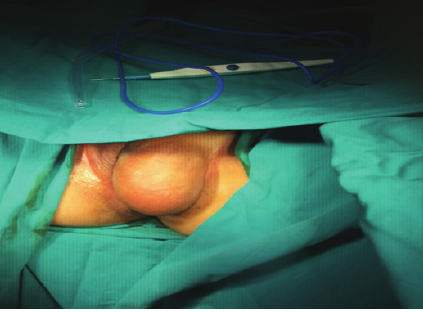
Figure 1: Intraoperative image of giant left vulvar cystic mass.